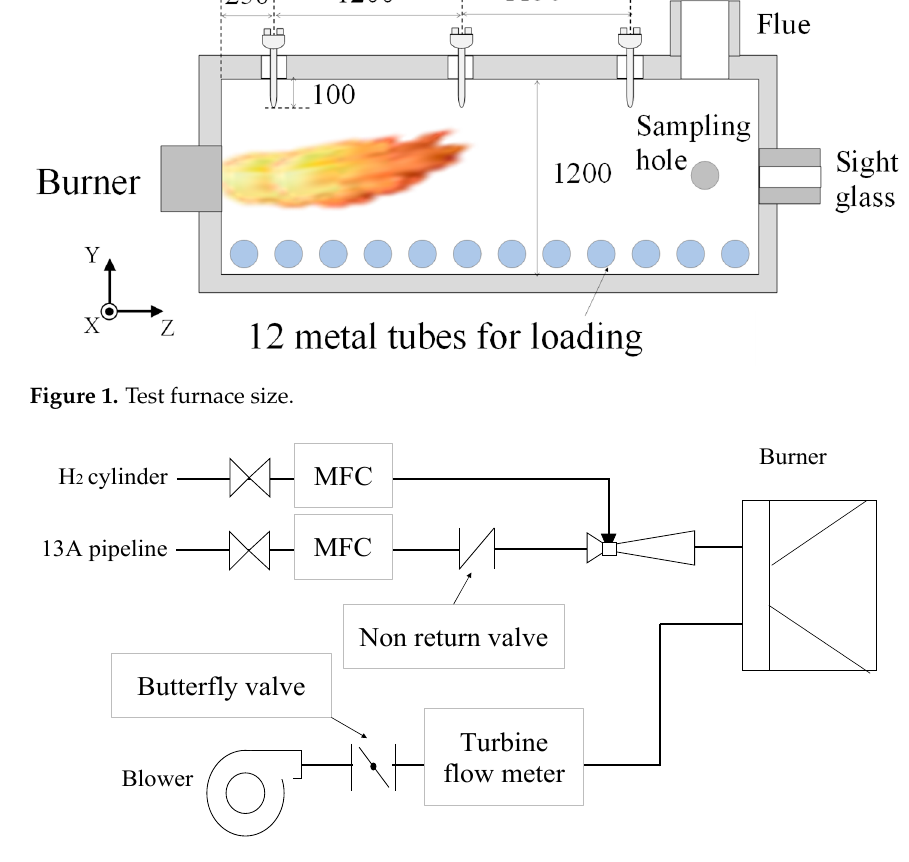
Figure 2. Pipe flow of test furnace burner.